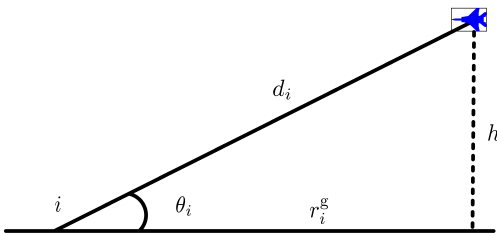
Figure 3. Parameters in ground-to-air